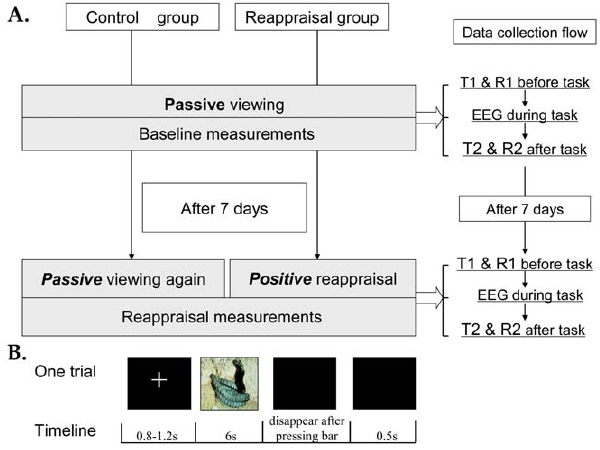
Figure 1. Experimental procedure. (A) The general procedure consists of a baseline day (day 1) and a test day (7 days later). On the baseline day, the participants of the control and reappraisal groups were asked to passively view the pictures. On the test day, the participants of the control group were again asked to passively view the pictures; however, the participants of the reappraisal group were asked to generate positive reinterpretations for the presented pictures. Both on the baseline and the test day, ERP was collected during, and SIgA samples (T1 & T2) and unpleasantness level of emotional states (R1 & R2) were collected before and after, the unpleasant pictures presen- tation block. (B) Timeline for events during each trial. Each picture was presented for 6 s with a random inter-stimulus interval of 0.8–1.2